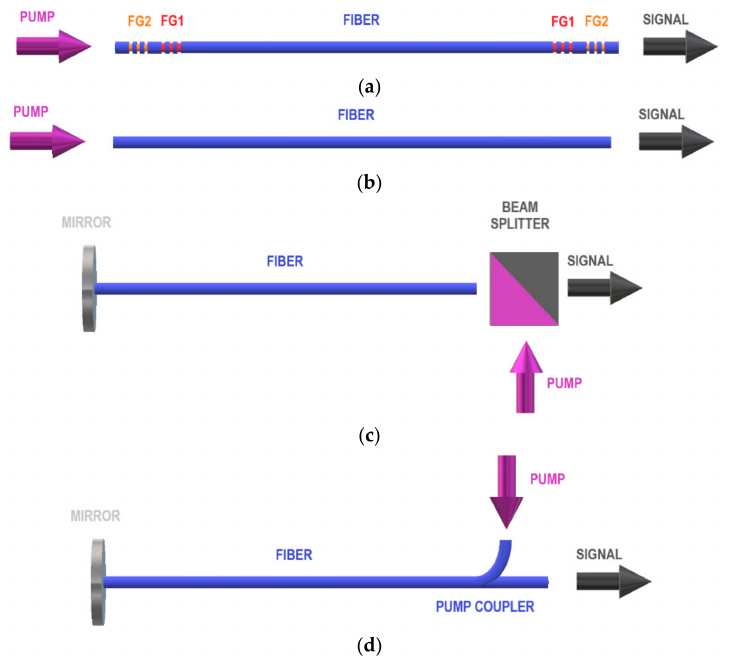
Figure 4. Schematic diagrams of cascade lasers ( a ) with fiber Bragg gratings FG1 and FG2; ( b ) consisting of the fiber only; ( c ) a structure using bulk optical elements and ( d ) all fiber structure using a pump